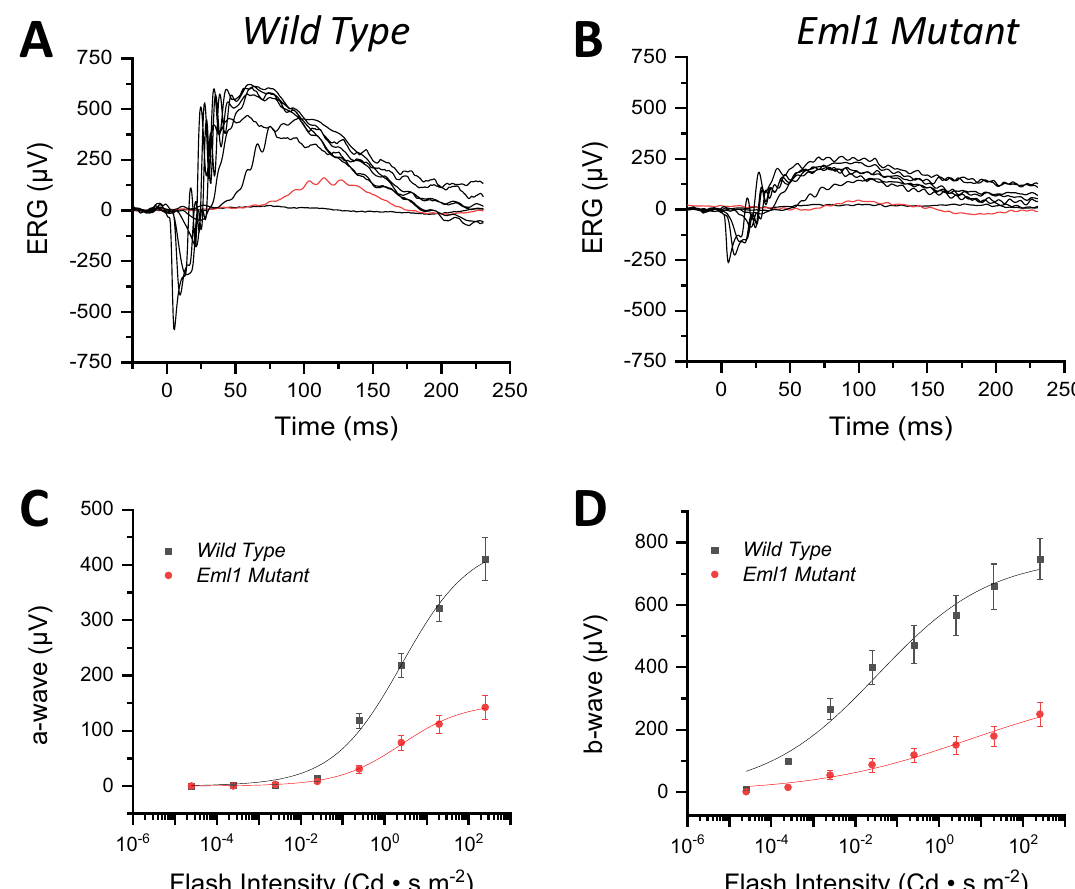
Figure 2. Effect of Eml1 mutation on retinal function. In-vivo ERG responses in scotopic conditions. Representative scotopic flash responses from wild type ( A ) and Eml1 mutant ( B ) mice. Flash intensities for both panels were (in Cd s m −2 ): 2.5 × 10 –5 , 2.5 × 10 –4 , 2.5 × 10 –3 , 2.5 × 10 –2 , 0.25, 2.5, 20 and 250. For comparison, the responses to a flash of 2.5 × 10 –4 Cd s m −2 are highlighted in red in the two panels. Averaged intensity-response data for the a-wave responses ( C ) and b-wave responses ( D ) from wild type ( black squares ) and Eml1 mutant ( red circles ) mice. The continuous lines represent a fit to the data with the Naka-Rushton function. Error bars show S.E.M for all